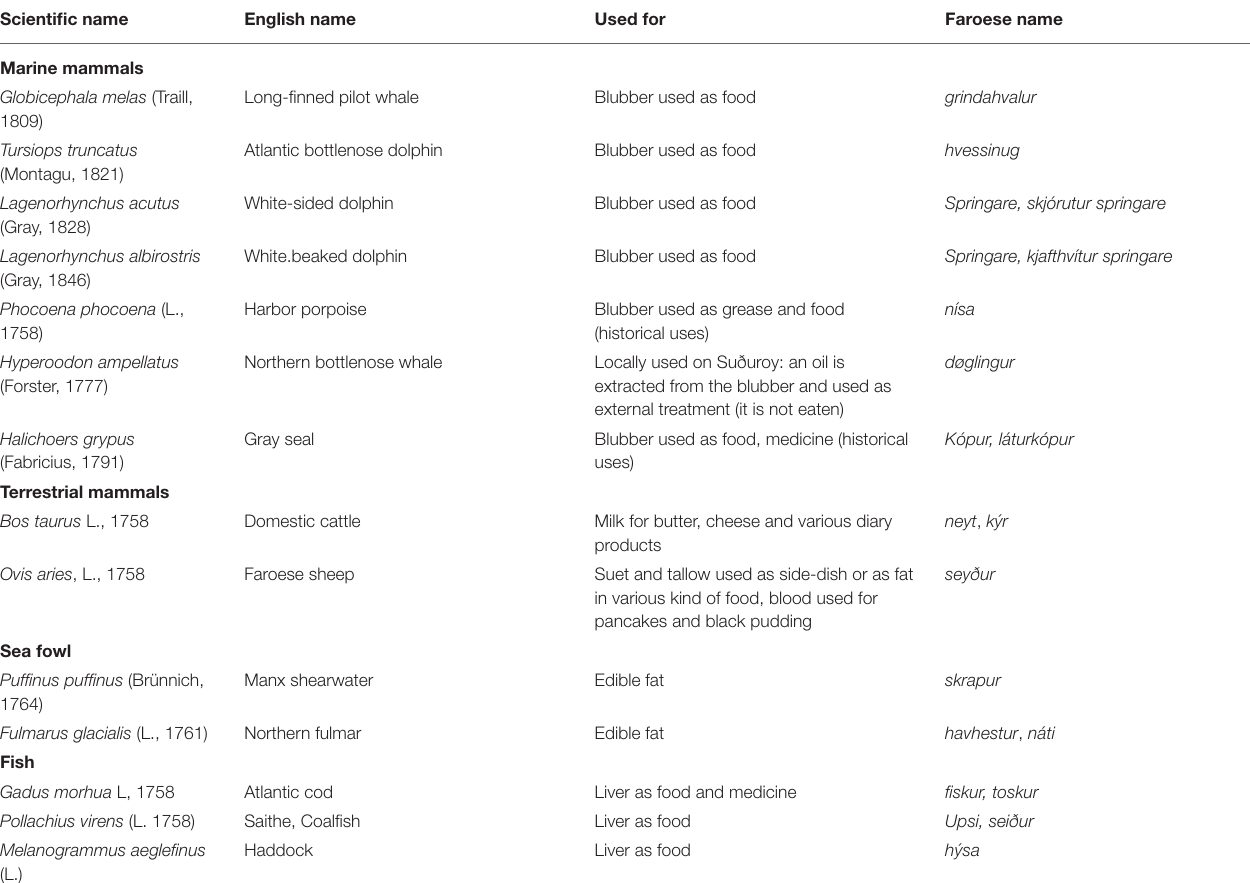
TABLE 1 | Main sources of animal and marine